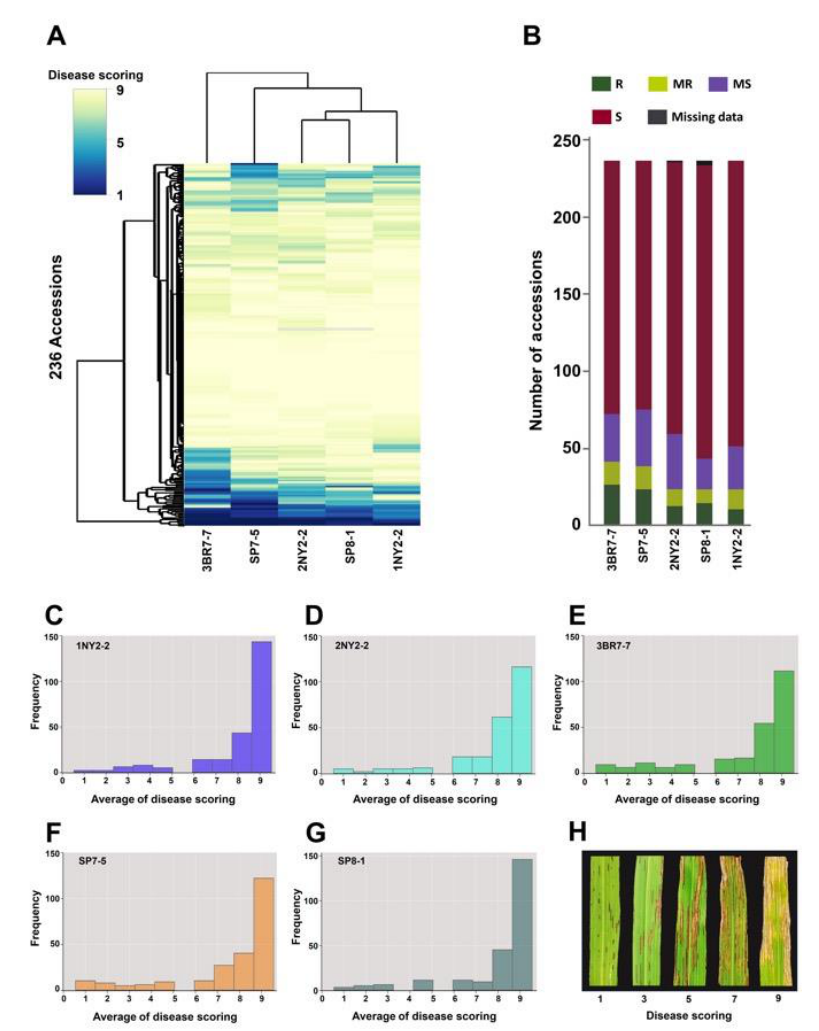
Figure 1. BLS disease reactions and scores of 236 rice accessions inoculated with representative isolates of Thai Xoc . ( A ) Hierarchical cluster of accessions and isolates based on BLS scores. ( B ) Number of accessions in R (scores of 1–3), MR (scores of 4–5), MS (scores of 5–7) and S (scores of 8–9) reactions. Distribution of the average BLS disease scores of 236 rice associations: (C–G): ( C ) 1NY2-2 isolate, ( D ) 2NY2-2 isolate, ( E ) 3BR7-7 isolate, ( F ) SP7-5 isolate and ( G ) SP8-1 isolate. ( H ) The scale 1–9 of disease scoring on infected leaves, (1 = resistant, 9 = susceptible).